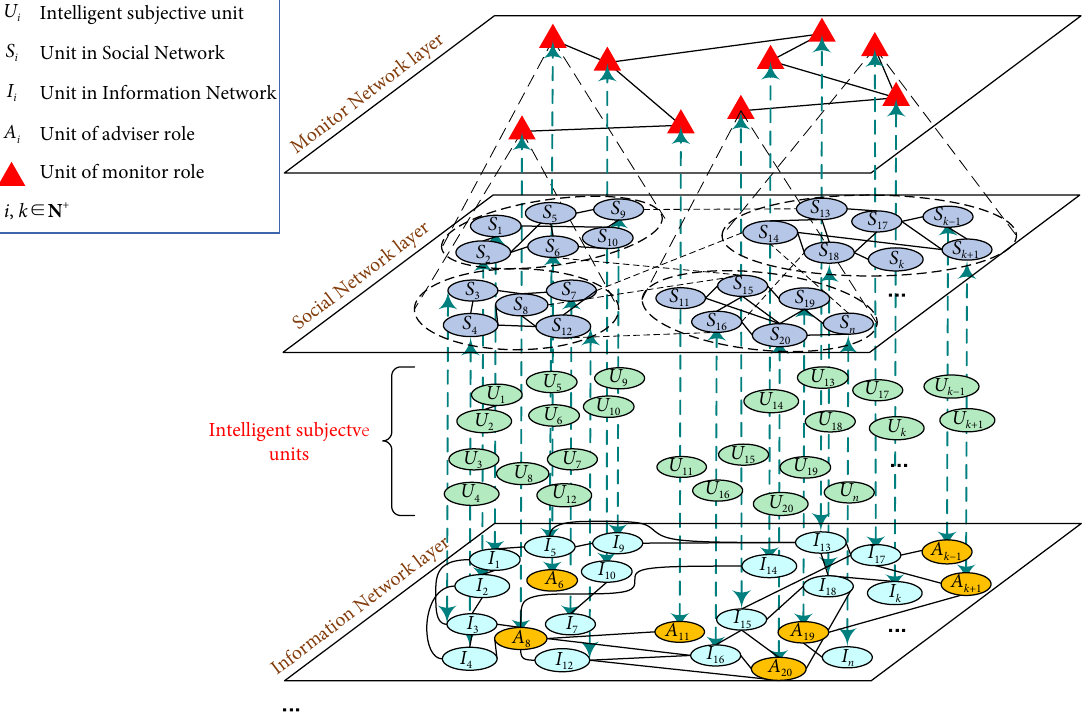
Fig. 3 Crowd Intelligence Network